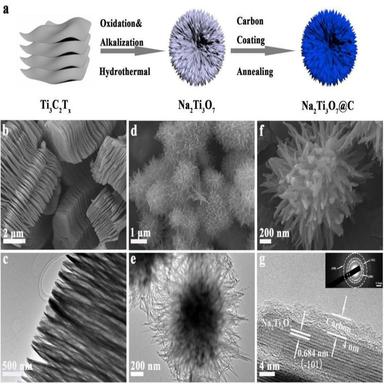
(a) Illustration of the route for synthesis of Na2Ti3O7@C. (b) FESEM and (c) TEM images of pure Ti3C2Tx. (d) Low-magnification FESEM and (e) TEM Na2Ti3O7. (f) High-magnification FESEM and (g) HRTEM images (the inset in (g) shows the corresponding SAED pattern) of Na2Ti3O7@C.